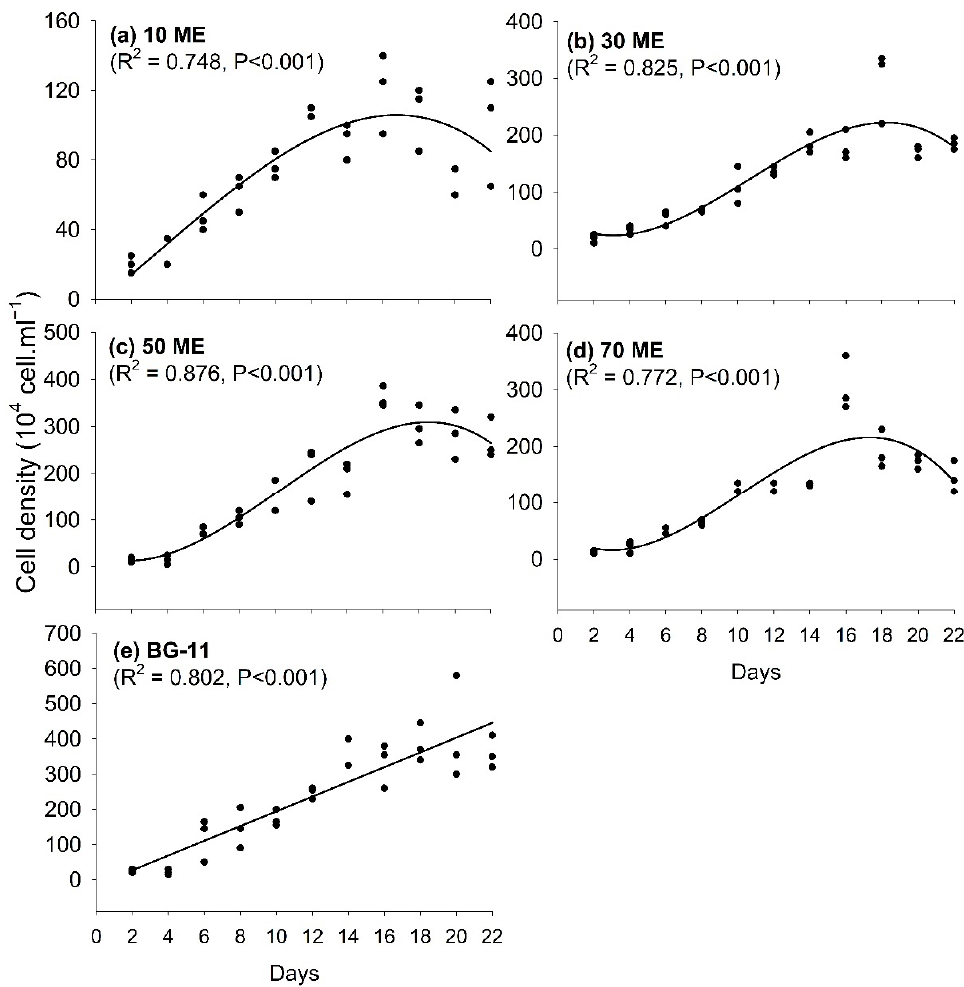
Figure 3. Variation of cell density of Chlamydomonas sp. in ( a ) 10 ME, ( b ) 30 ME, ( c ) 50 ME, and ( d ) 70 ME of malting effluent and ( e ) BG-11 standard mineral media during 22 days of cultivation time. The regression lines are derived from polynomial third-order regression.